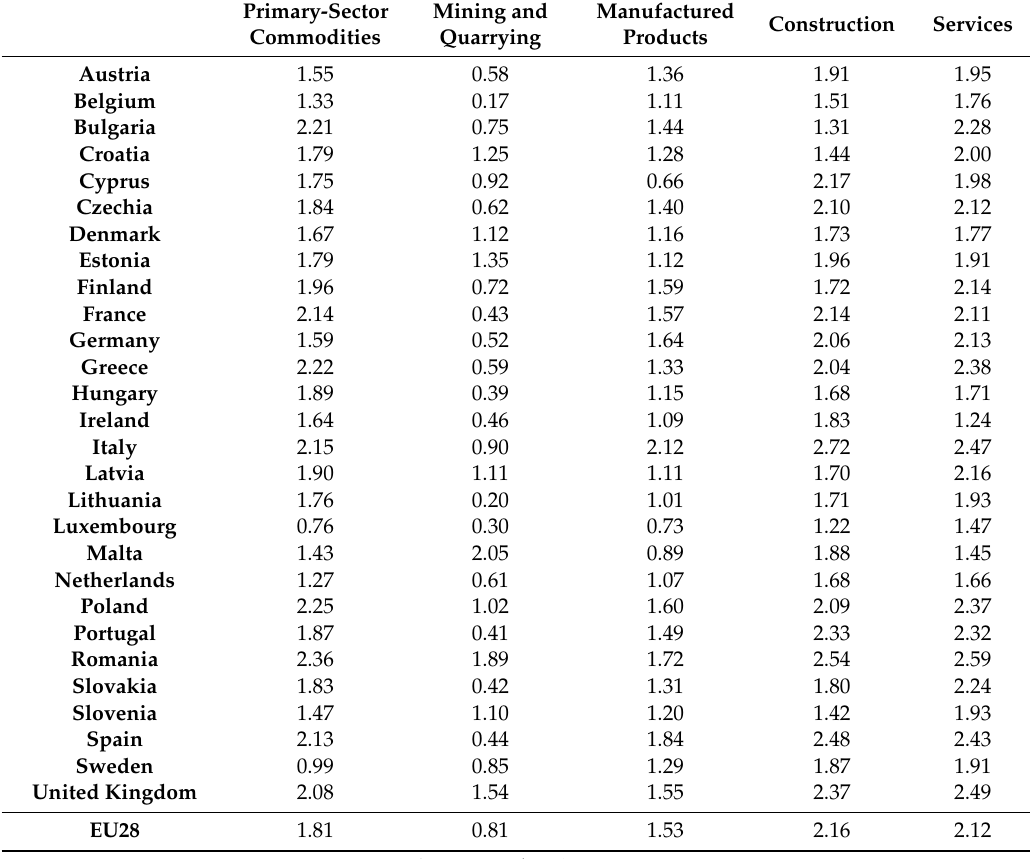
Table A2. Average output (millions of euros) reduction per 1 million euros of demand